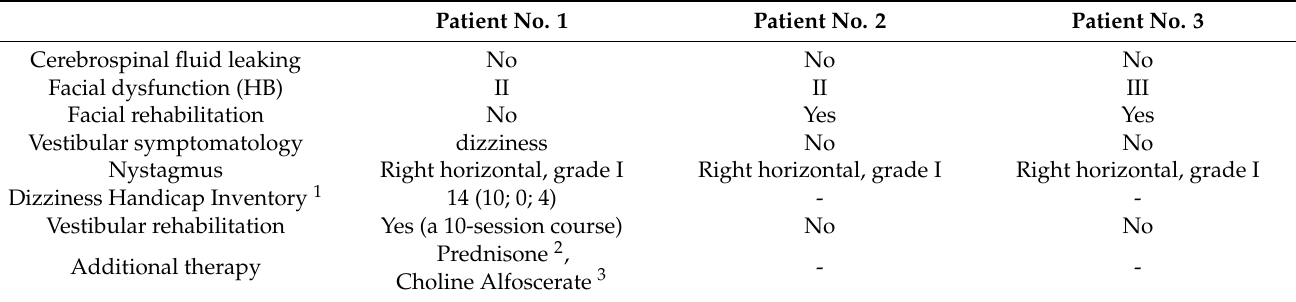
Table 2. Postintervention participants’